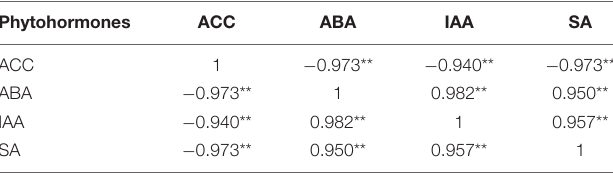
TABLE 5 | The correlations between 1-aminocyclopropane-1-carboxylic acid (ACC), abscisic acid (ABA), indole-3-acetic acid (IAA), and salicylic acid (SA) in 0- and 72-h groups.